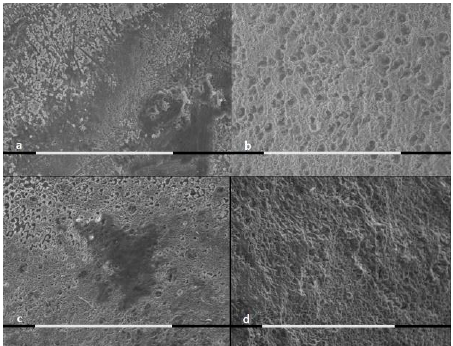
Figure 2. SEM pictures (800×, marker 100 μ m) of enamel exposed to hydrochloric acid for 5 min: ( a ) enamel brushed with AZ ProExpert ® toothpaste; ( b ) untreated controls; ( c ) enamel treated with Colgate Total Original ® toothpaste; and ( d ) untreated controls.